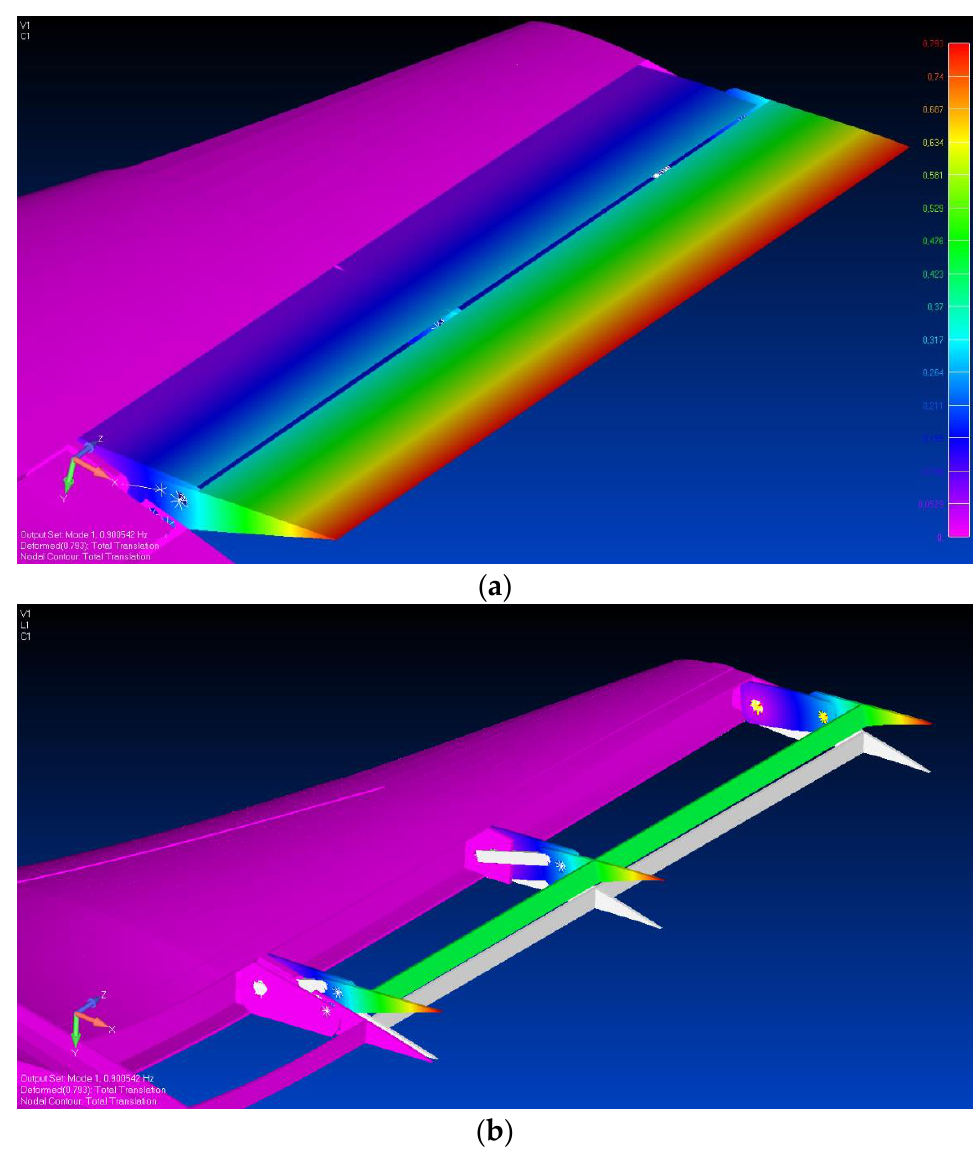
Figure 5. Free play floating mode of the upper morphing tab (frequency = 0.9 Hz). ( a ) Morphing aeroshape mechanism; ( b ) Detail of the undeformed and deformed ribs.